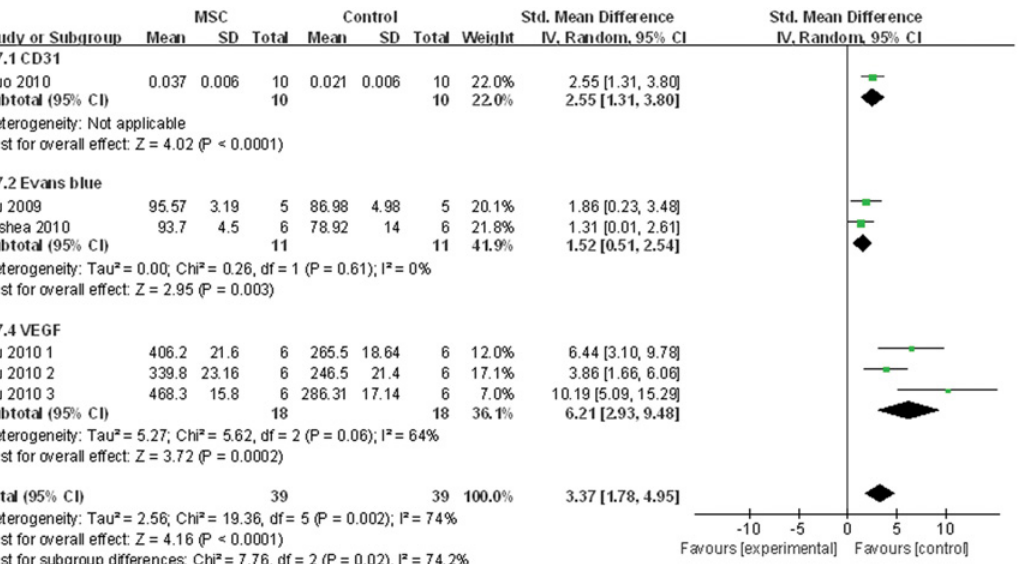
Fig 6. Forest plot showing the impact of mesenchymal stem cell (MSC) therapy on re-endothelialization, compared with controls. CD31, Evans blue, and vascular endothelial growth factor (VEGF) were used as the indices reflecting the degree of re-endothelialization. Abbreviations: SD = standard deviation, IV = independent variable, 95% CI = 95% confidence interval, CD31 = the expression ratio of CD31, VEGF = vascular endothelial growth factor, Evans blue = the ratio of re-endothelialized area (defined as the area not stained with Evans blue/total injured surface area).